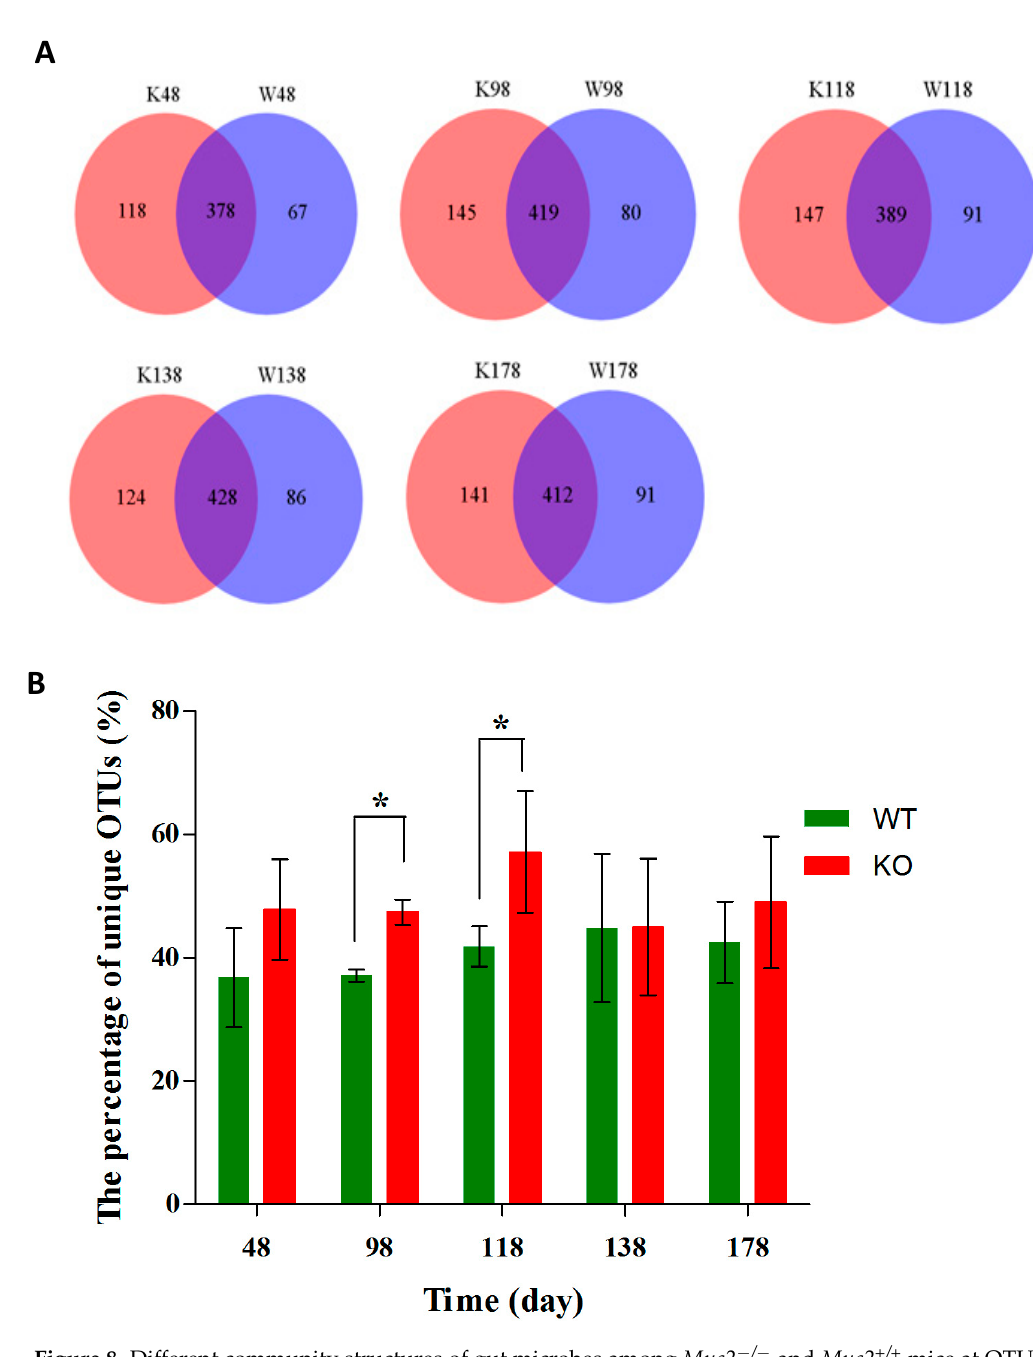
Figure 8. Different community structures of gut microbes among Muc2 − / − and Muc2 +/+ mice at OTU level and at different time points. ( A ) The Venn diagrams showed the common and unique OTUs at different time points; ( B ) the percentage of unique OTUs. * indicated the significant differences ( p < 0.05) between Muc2 − / − and Muc2 +/+ mice. W, Muc2 +/+ mice; K, Muc2 − / − mice. The sample names represented the sampling time and genotypes. For example, W48 indicated the samples collected from Muc2 +/+ mice at day 48, and the K48 indicated the samples collected from Muc2 − / − mice at day 48.